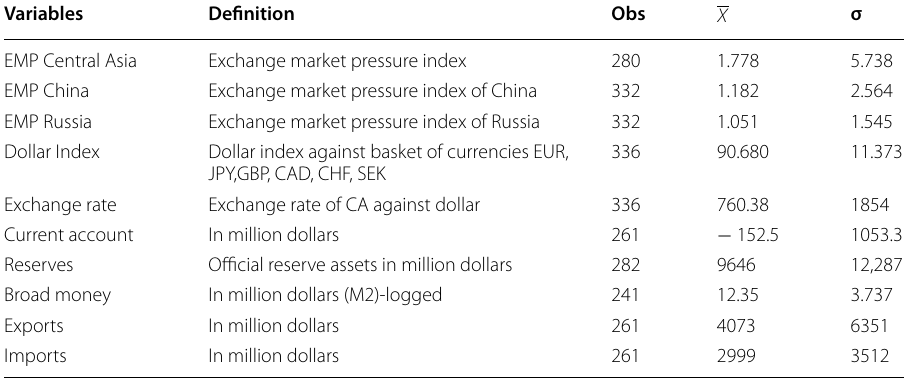
Table 1 Variable definitions and summary